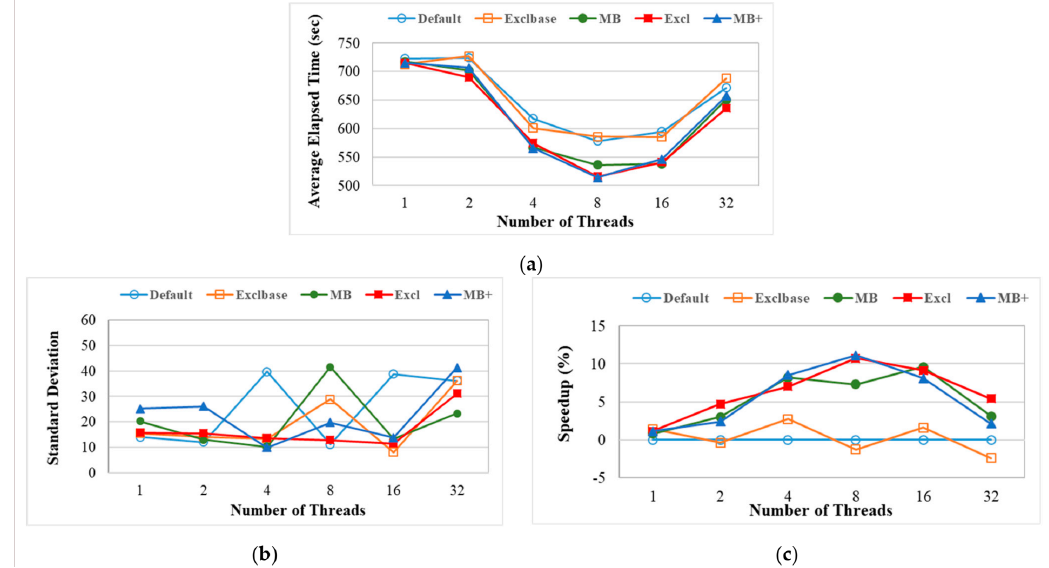
Figure 11. Experimental results for different numbers of threads. ( a ) Average elapsed time of each test case; ( b ) Standard deviation of each test case; ( c ) The performance increase over the unmodified Linux